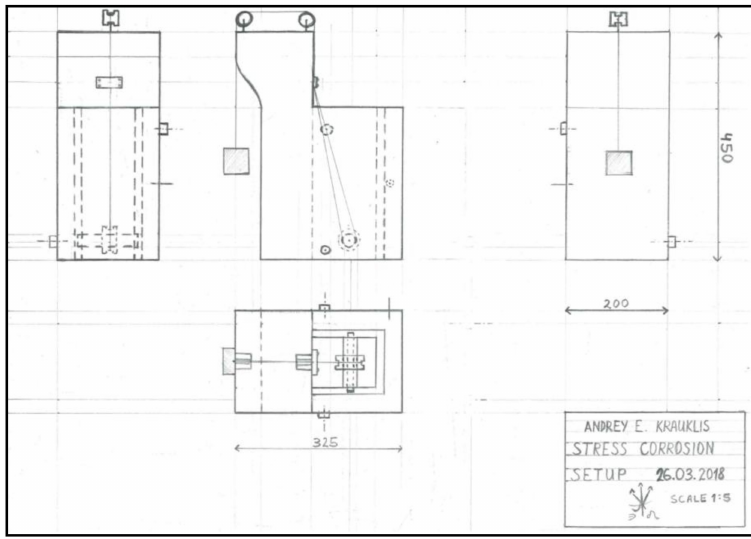
Figure A1. The design schematics of the stress corrosion rig for the glass fibre bundles, indicating the placement of the fibres and the